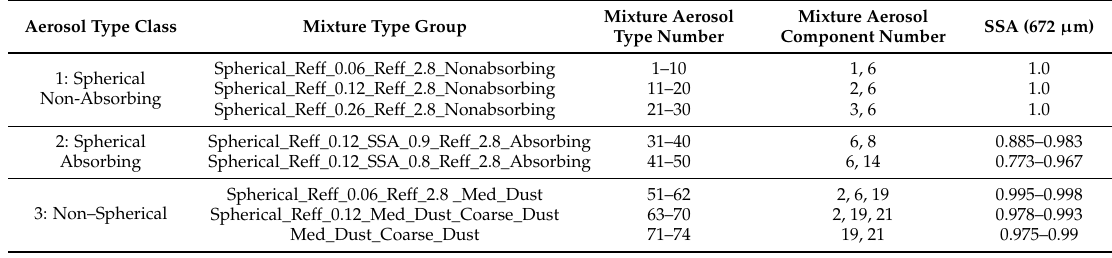
Table 3. MISR Aerosol Type Mixture.